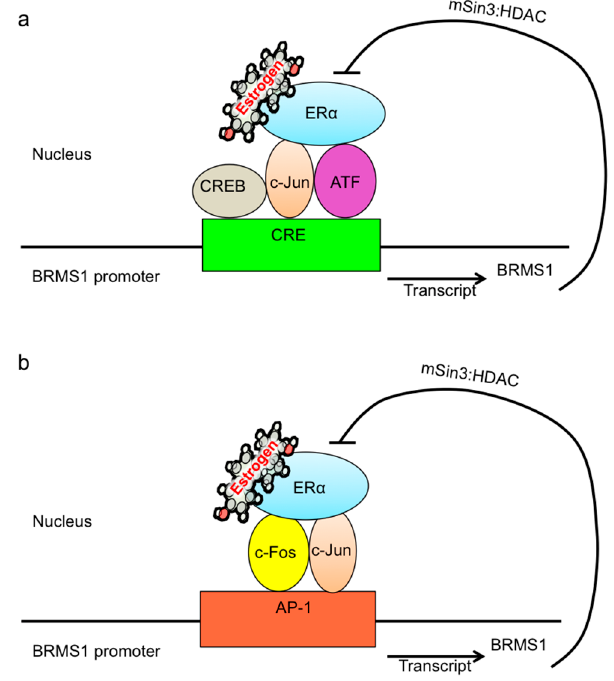
Figure 7. A proposed model for the relationship between ER α and BRMS1. ( a ) The BRMS1 5 ′ upstream region shows several putative regulatory elements, one of them is the binding site for CREB. ER α may regulate gene expression as a co-regulator on other promoter sites. ER α has been shown to bind c-Jun/ATF proteins, which bind to the CRE of the cyclin D1 promoter, inducing its expression. This suggests that ER α may induce BRMS1 expression by binding transcriptional complexes on the CRE in the promoter region of BRMS1; ( b ) It has been shown that ER α upregulates gene transcription by binding the AP-1 complex on AP-1 response elements. This information, taken together, suggests that ER α may induce BRMS1 expression through binding transcriptional complexes as a co-activator on other promoter sites (e.g., CRE and AP-1).